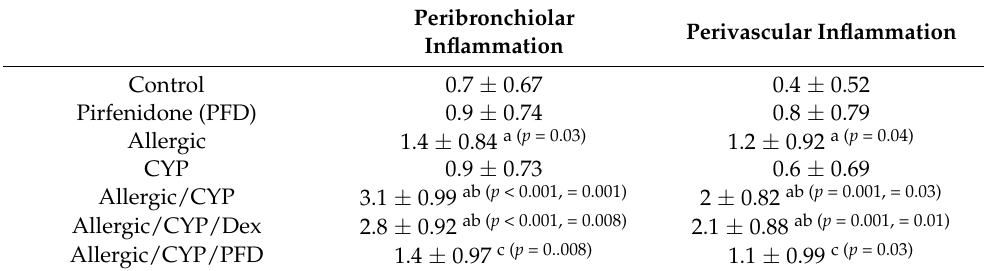
Table 4. The effect of PFD on the peribronchial and perivascular mononuclear cellular infiltration in the lung tissues of the studied groups at the end of the